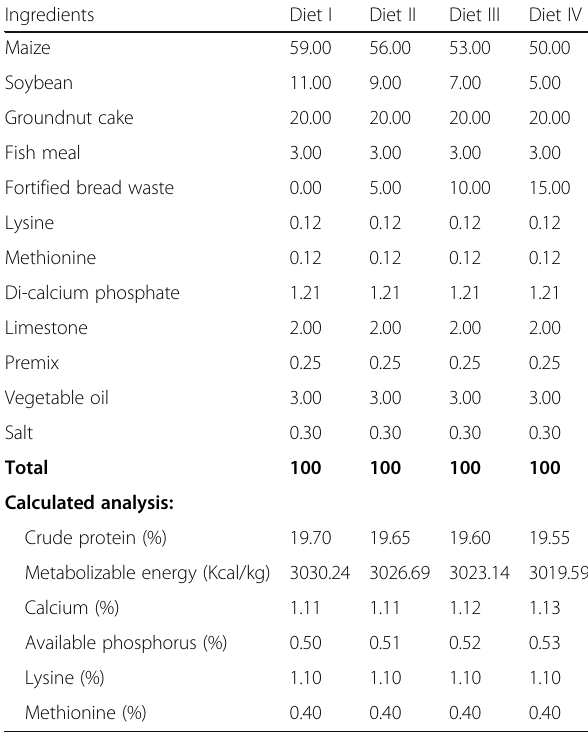
Table 1 nutritional composition of bread waste and fortified